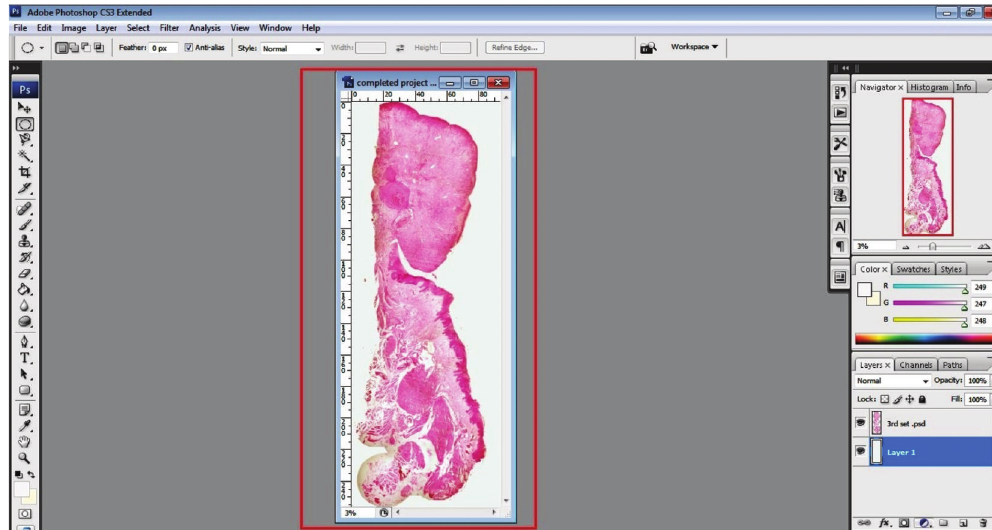
Figure 10: The final “stitched” image of multiple microphotographs. Minor adjustments like background color are applied to make it more uniform and appealing. Note the red boxes in the figure. Follow them for an easy workflow.